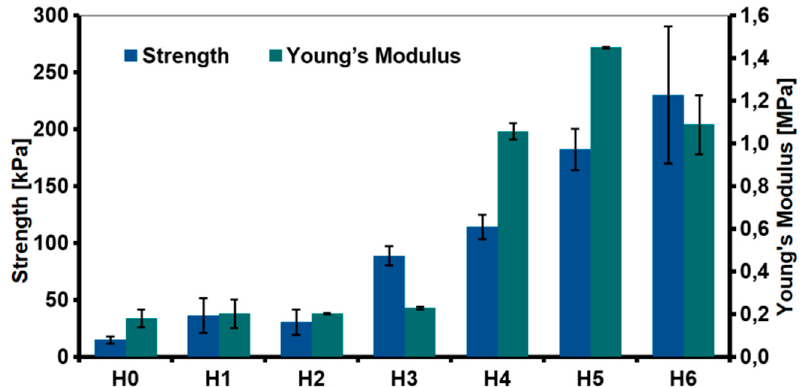
Figure 11. Mechanical properties (compressive strength and Young’s modulus) of the hydrogels (H0: chitosan (CS); H1: CS/graphene oxide (GO); H2: CS/poly(ethylene glycol) grafted graphene oxide (GO-PEG); H3: CS/reduced graphene oxide (rGO); H4: CS/GO/hydroxyapatite (HAp); H5: